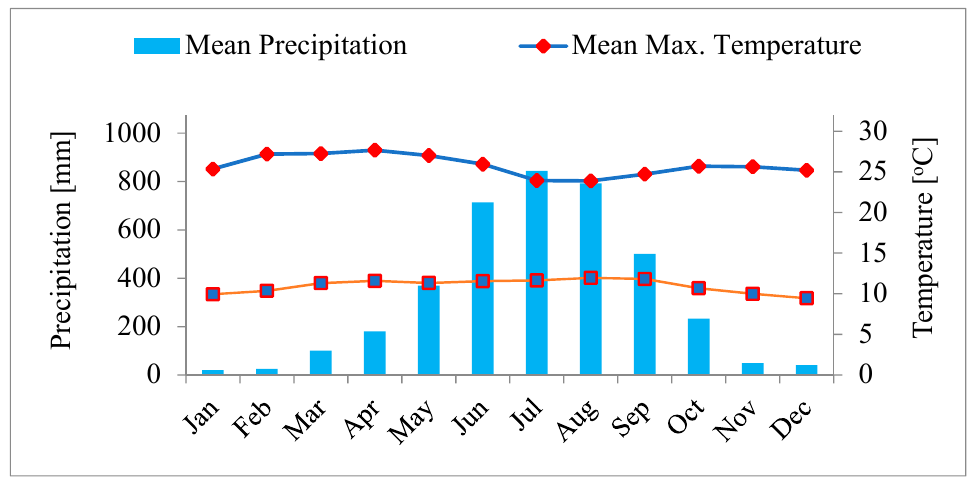
Figure 3. Average monthly rainfall, minimum and maximum temperatures in the Fincha’a watershed.